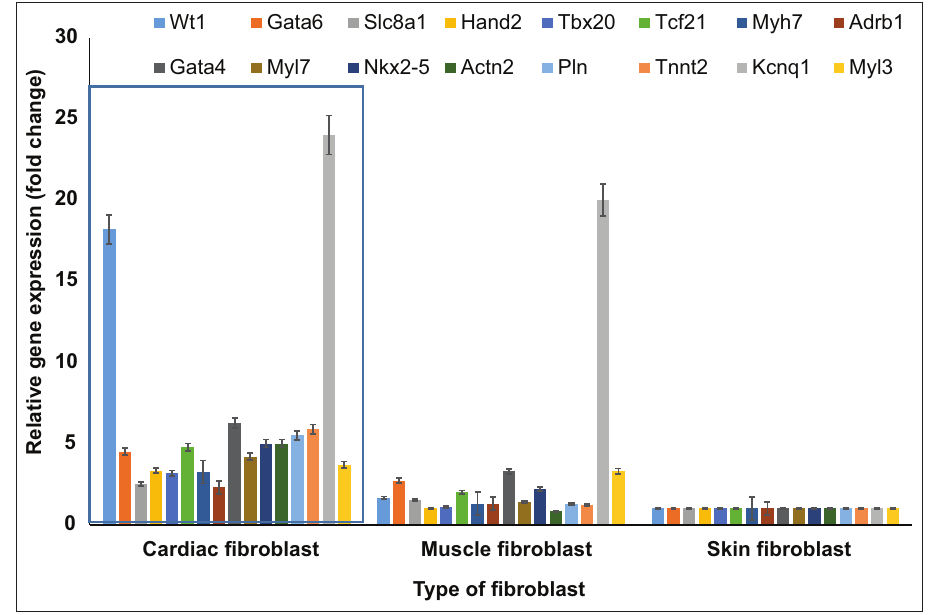
Figure-3: Comparative gene expressions of cardiogenic genes among cardiac, muscle, and skin fibroblasts. The gene expression of the skin fibroblasts was set to 1, and the gene expressions of muscle and cardiac fibroblasts were calculated relative to skin fibroblasts. All cardiogenic genes had higher levels of expression (p<0.01) in cardiac fibroblasts (in the rectangle) than in muscle and skin fibroblasts. The high expression of Wilms tumor 1 was very specific to cardiac fibroblast. Cell culture was done in six replications while quantitative polymerase chain reaction was done in three